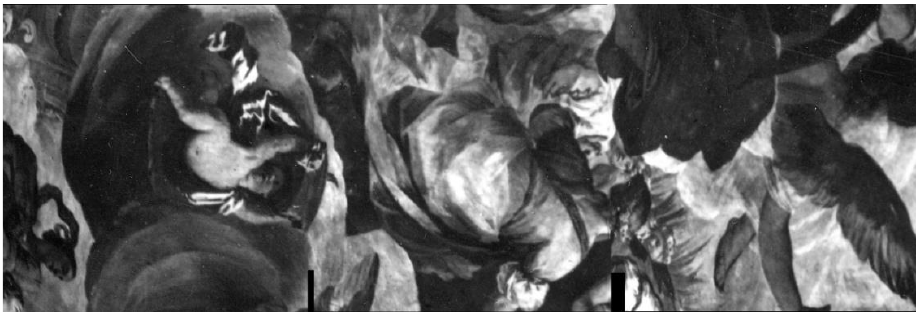
Figure 11. Partial mosaic calculated from the video projection positions.